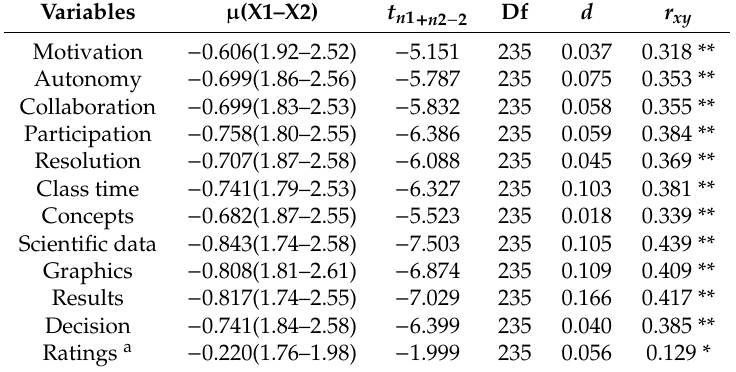
Table 5. Study of the value of independence between the control groups and the experimental